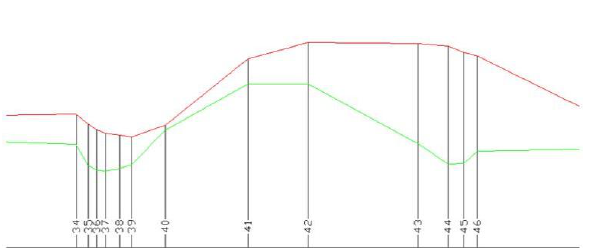
Figure 13. Example of area for which DTMs overestimate elevation. Topographic survey in green, last pulse DSM interpolation in red.